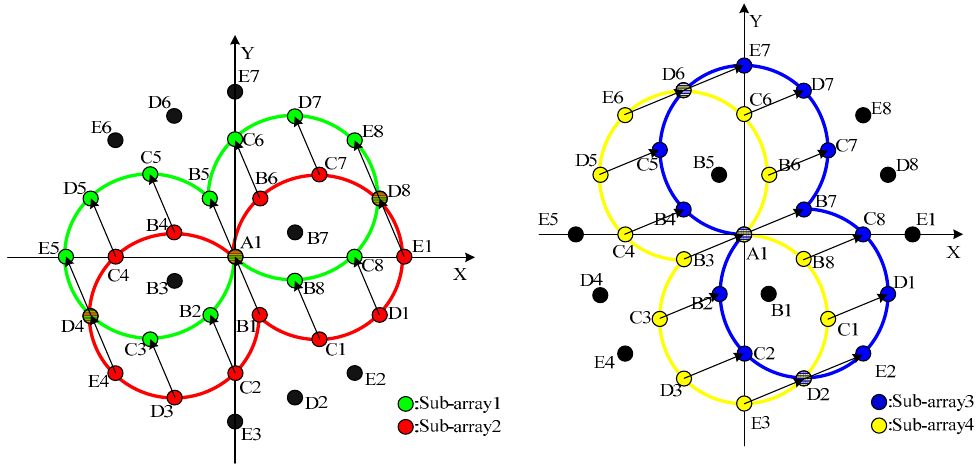
Figure 5. Two pairs of sub-arrays with the property of rotational invariance.